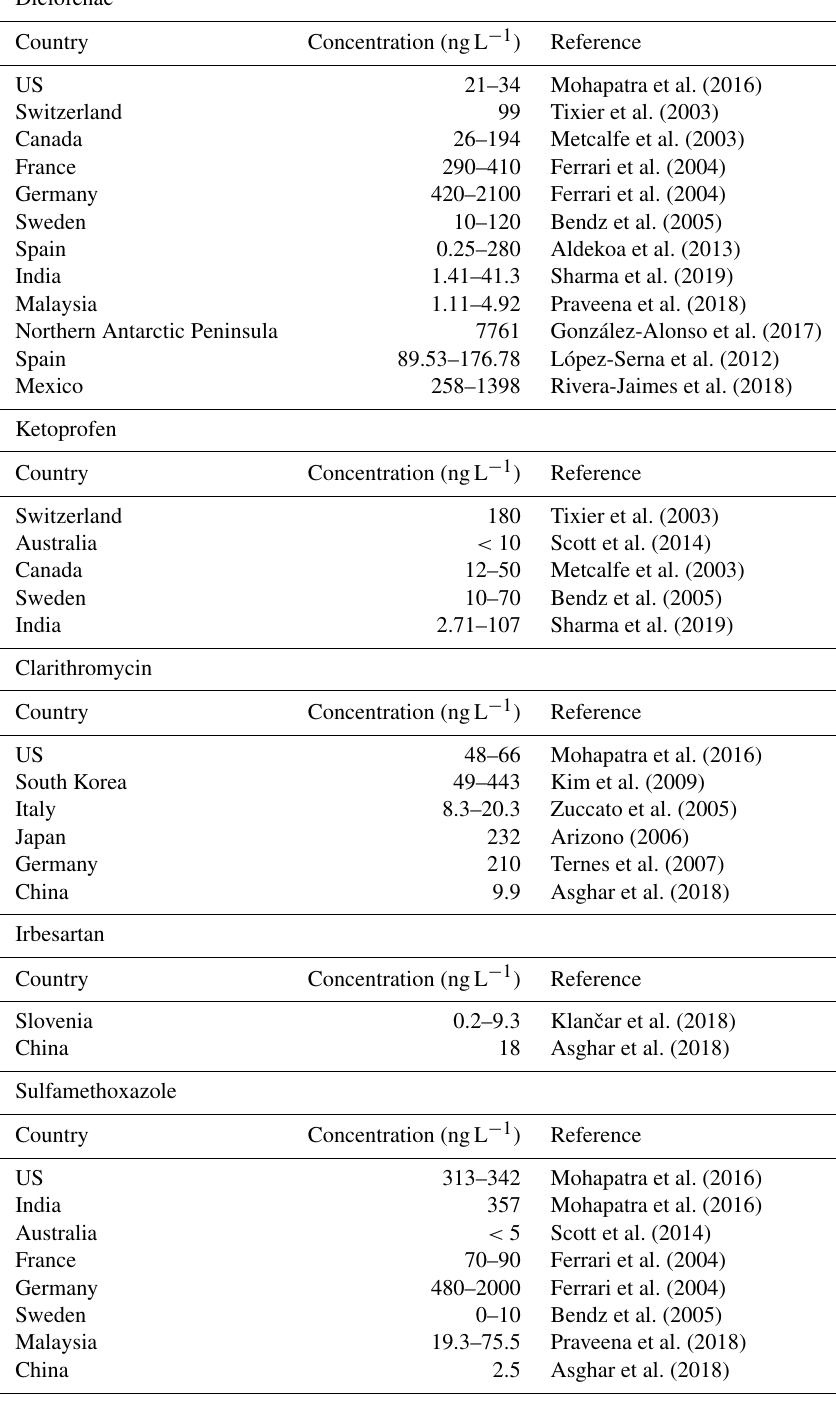
Table 1. Concentrations of the five selected pharmaceuticals recorded in surficial waters